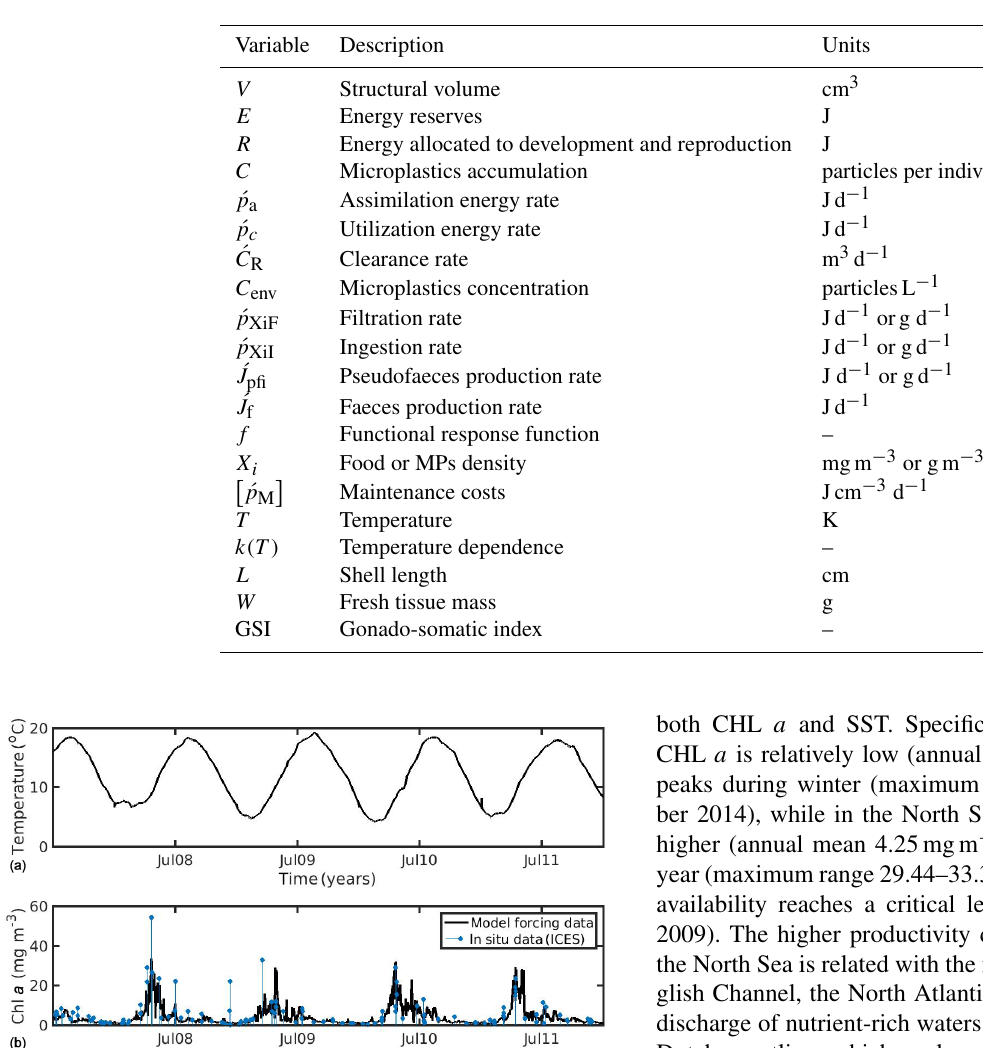
Table 2. Dynamic energy budget model: variables